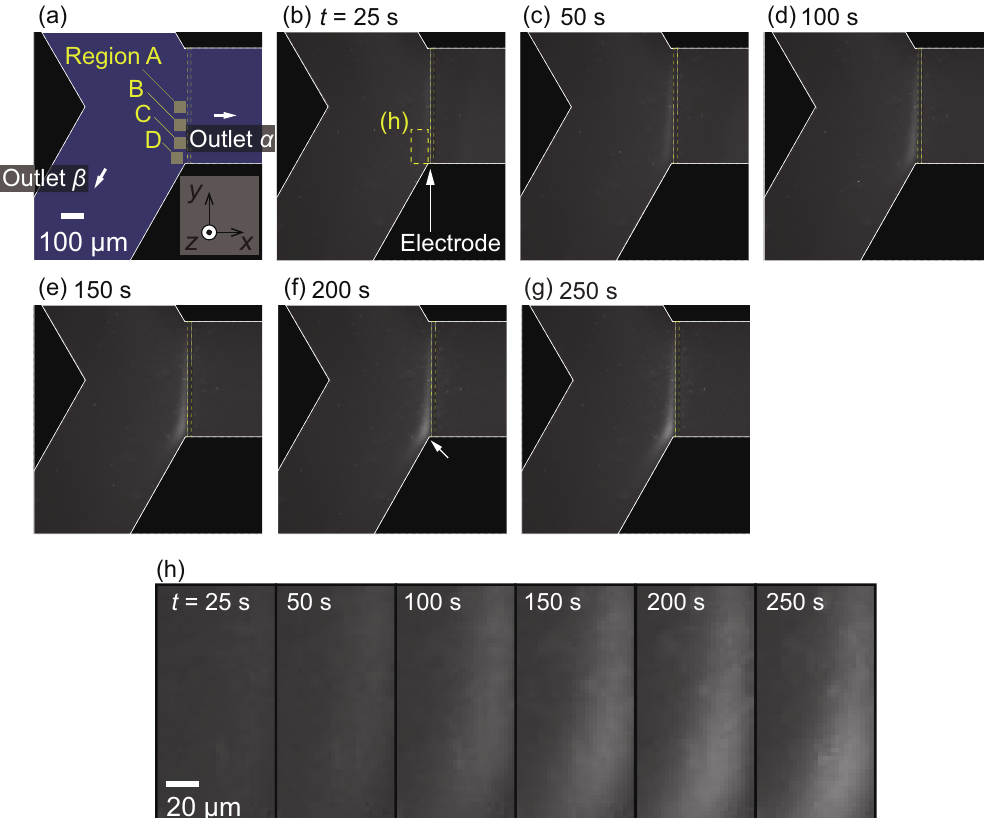
Figure 5. ( a ) Schematic figure of the test section and the positions of region A, B, C, and D analyzed in Figure 6; ( b – g ) Time series of the nanoparticle fluorescence. The particle flow separation is induced by microscale thermophoresis for the case with a particle diameter d = 100 nm and ∆ P = 1.0 Pa. At t = 0 s, the heating by the electrode is initiated. Particle flow from the inlet is separated at the Y-shaped branch. Because the thermophoresis is directed to the colder region, the PS particles cannot enter the outlet α . ( h ) Magnified figures of ( b – g ) for a rectangular region indicated in ( b